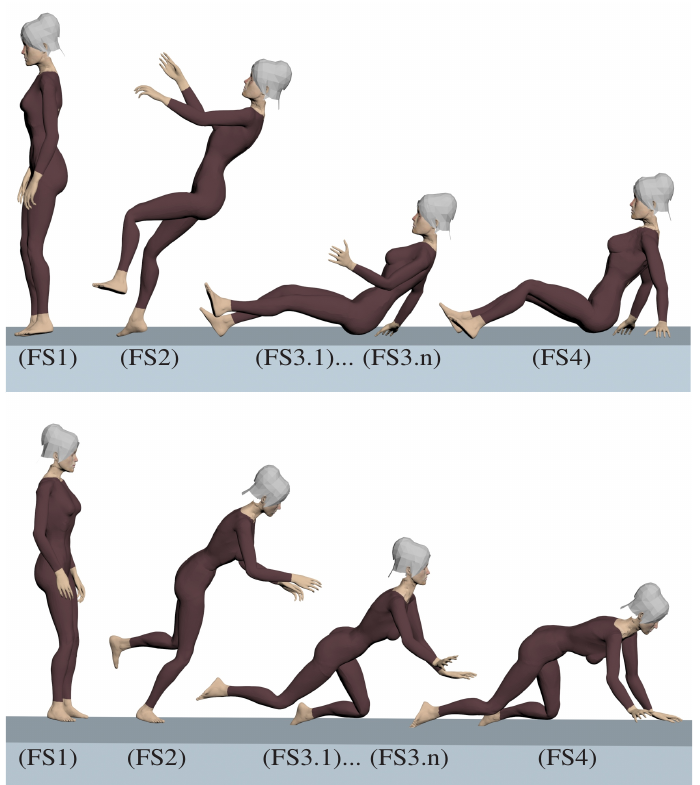
Figure 3. Backwards and forwards